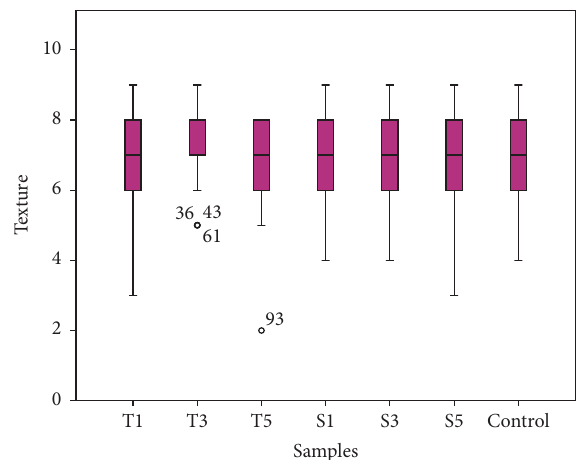
Figure 7: Box-plots obtained for the texture of prepared cake samples.